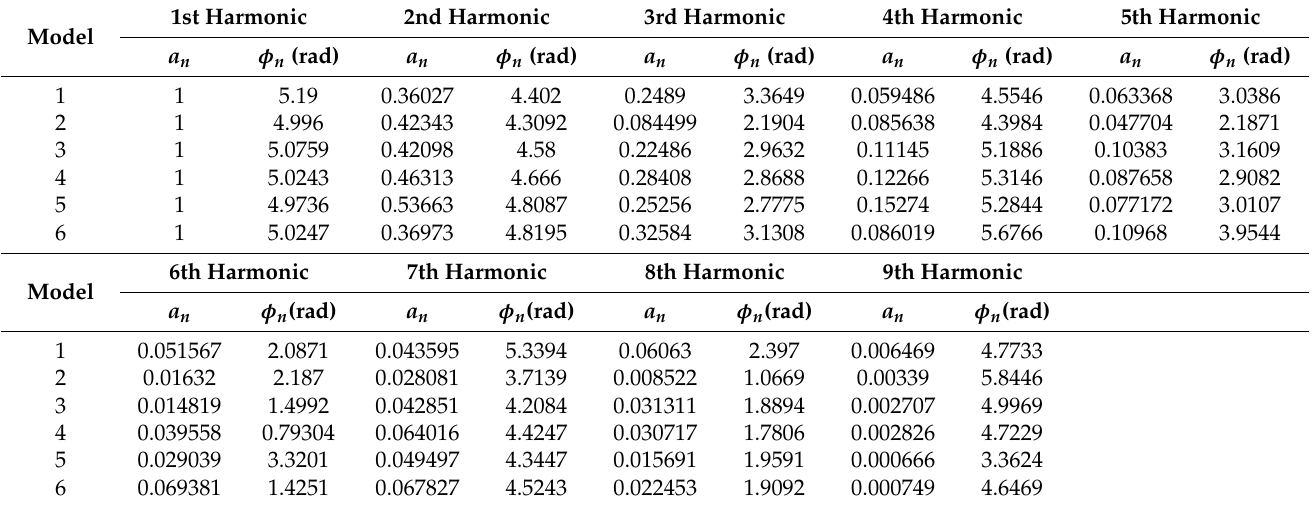
Table 2. Coefficients of harmonic models of gyro signals of the six most common thigh angle patterns.